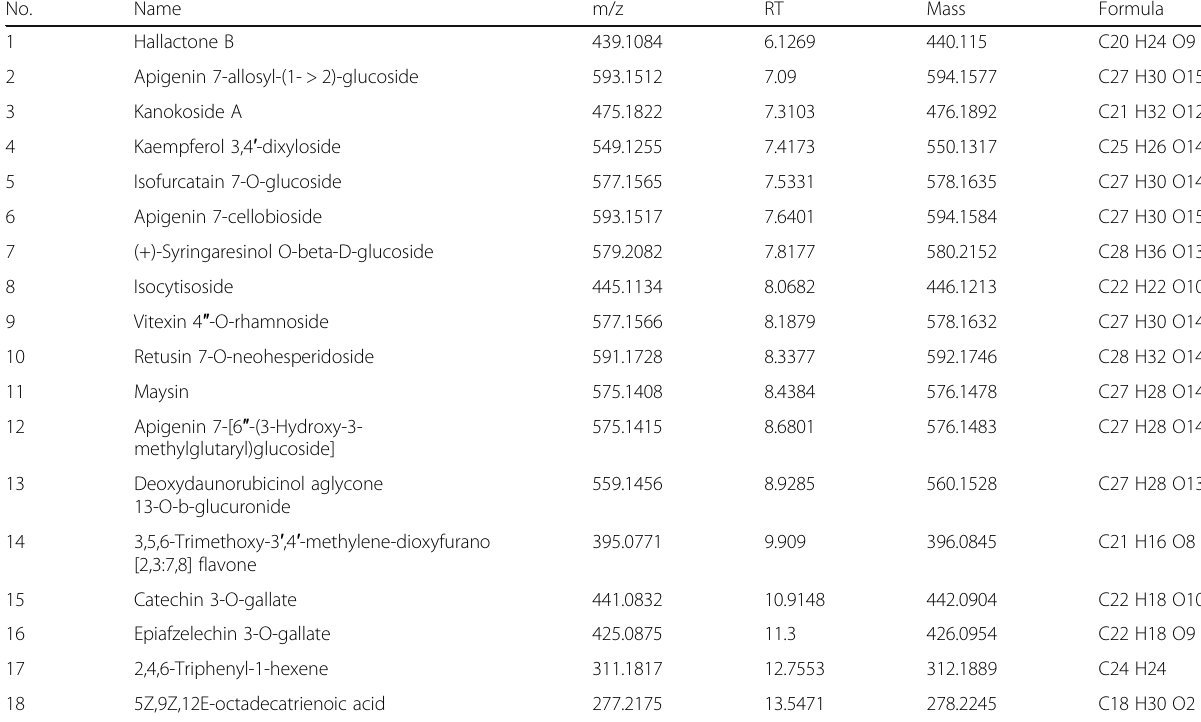
Table 1 Major Chemical Composition Detected in DBB Extracts using LC/MS